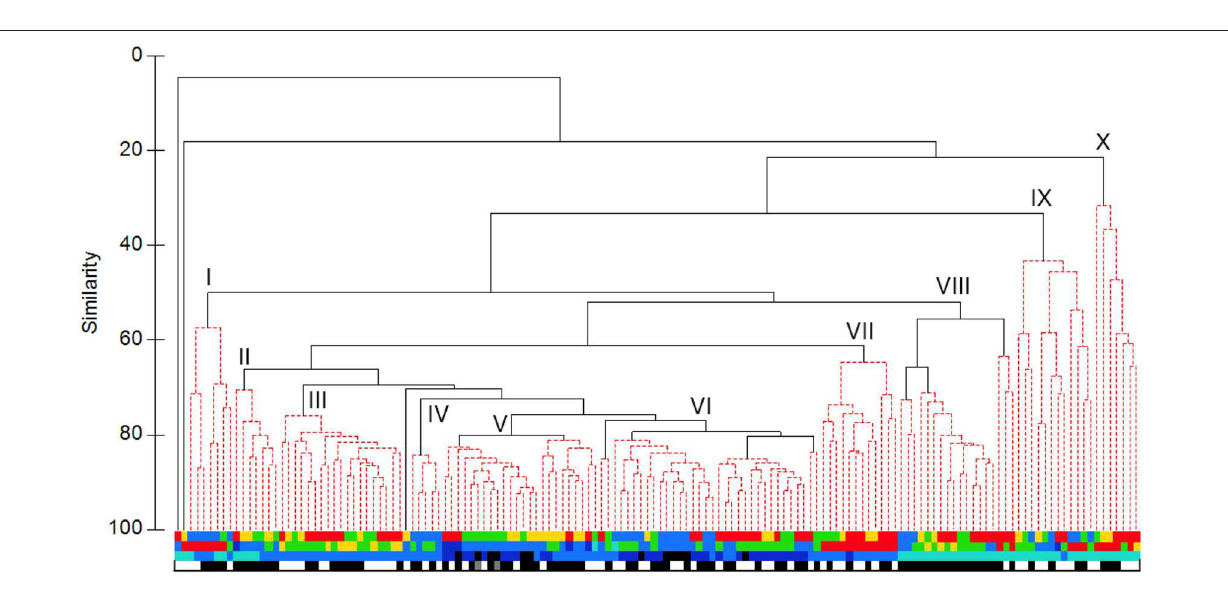
from those on either of the others. Those taken on the Wall Station differed from the Deep and Offshore